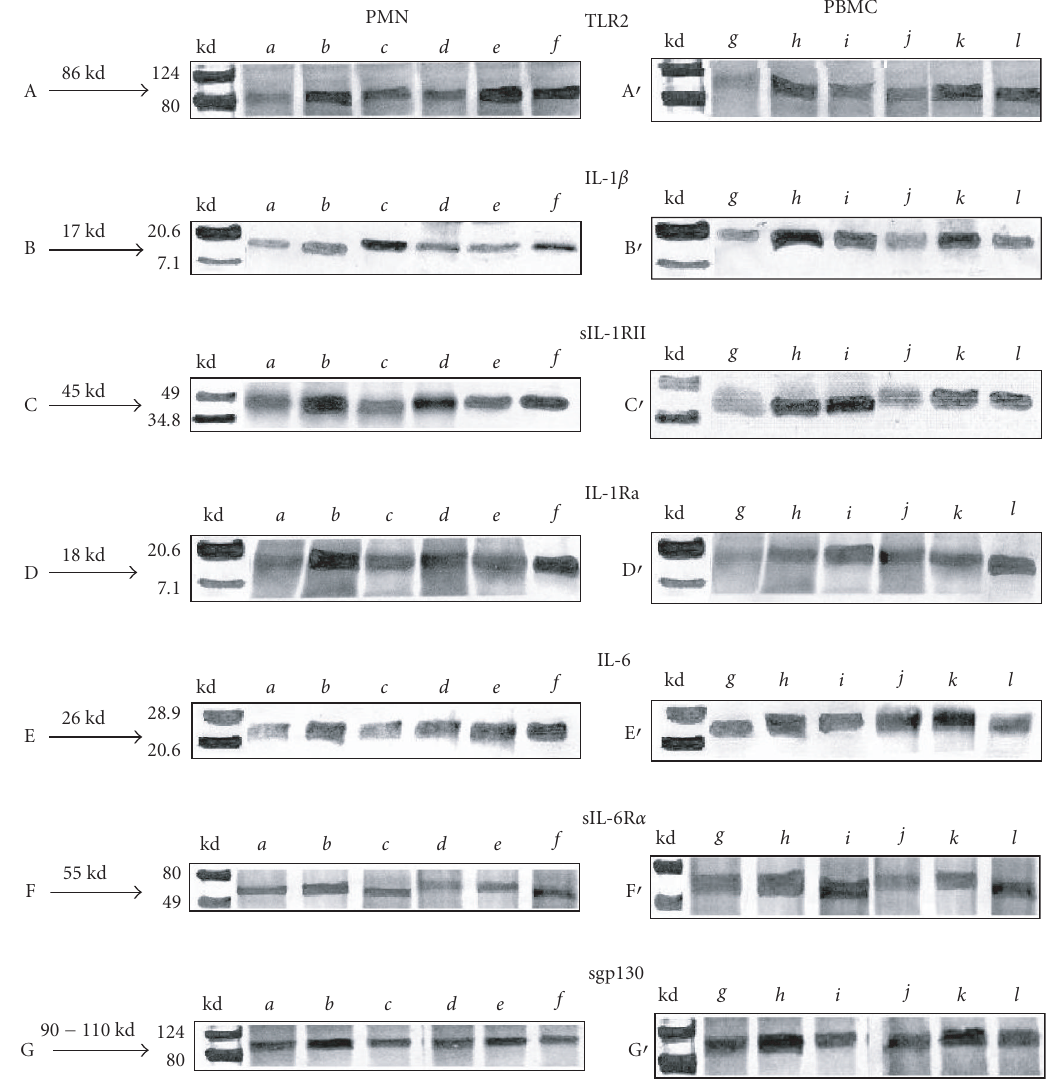
Figure 1: Western blot analysis of TLR2 and IL-1 β , sIL-1RII, IL-1Ra, IL-6, sIL-6R α , sgp130 in human PMN and PBMC cells from control and patients with Lyme disease. a : PMN of control. b : PMN+LPS of control. c : PMN+rhIL-15 of control. d : PMN of patients. e : PMN+LPS of patients. f : PMN+rhIL-15 of patients. g : PBMC of control. h : PBMC+LPS of control. i : PBMC+rhIL-15 of control. j : PBMC of patients. k : PBMC+LPS of patients. l : PBMC+rhIL-15 of patients.